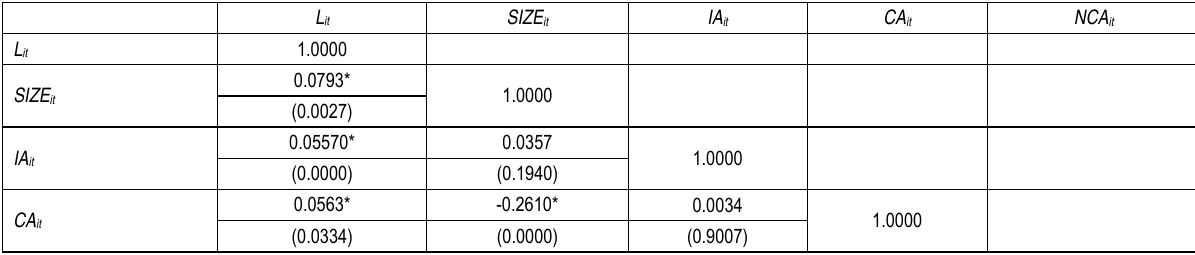
Table 4. Correlation matrix, Model I